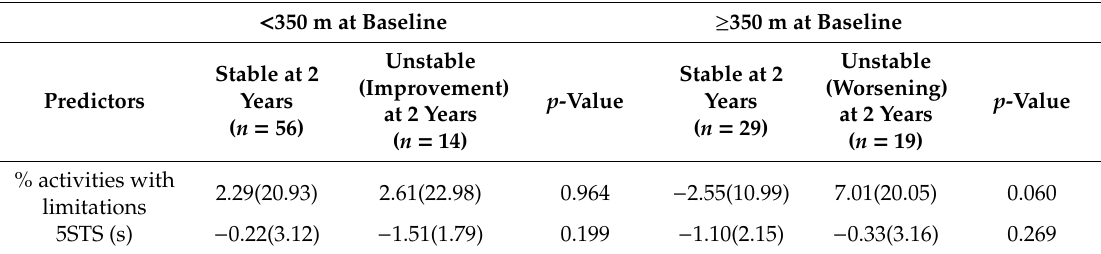
Figure 3. Mean of mobility activities with limitations ( a ) and 5STS test times ( b ) at T1 and T2 between stable (1) and unstable (2) patients who had poor 6MWT performance at baseline. Table 4. Mean change between T1 and T2 in the five-repetition sit-to-stand motion test (5STS) and mobility activities with limitations between stable and unstable patients who had poor and non-poor 6MWT performance status at baseline. < 350 m at Baseline ≥ 350 m at